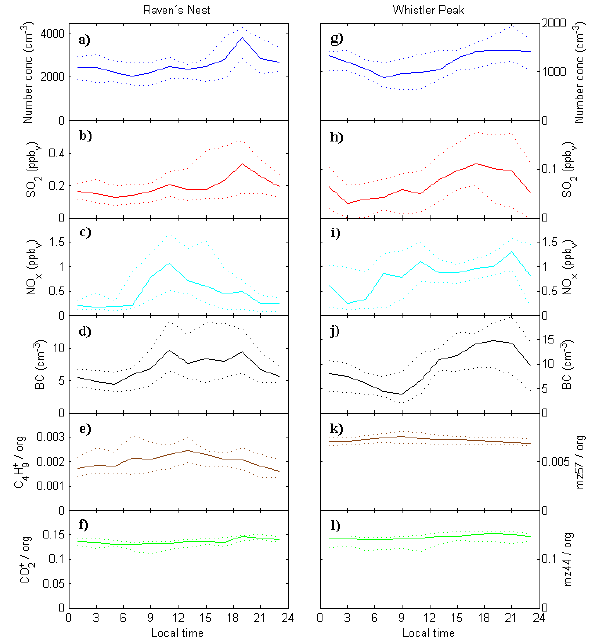
Fig. 8. Median diurnal cycles 13-22 July of total integrated SMPS particle number concentration, SO 2 , NO x , and BC at Raven’s Nest (a-d), and Whistler Peak (g-j). The ratios of C 4 H 9+ and CO 2+ to total organic concentration at Raven’s Nest (e-f), and the ratios of m/z 57 and m/z 44 to total organic concentration at Whistler Peak (k-l). Dotted lines represent 25 and 75 percentiles, respectively.